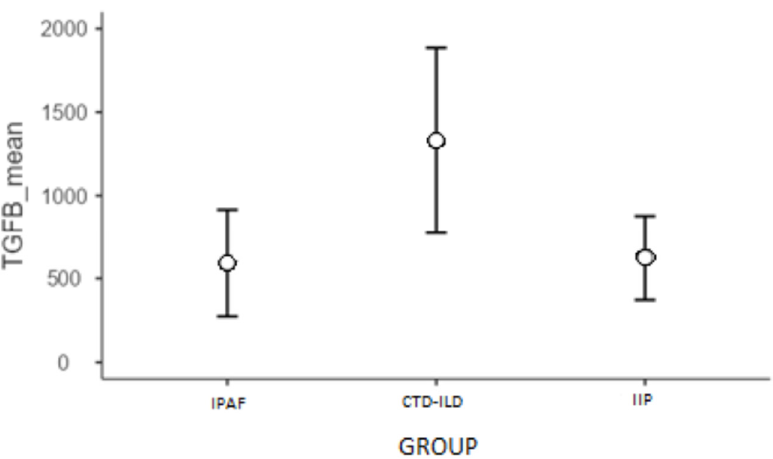
Figure 5. Estimated marginal means for TGF- β 1 by group membership. Graph 2. Estimated marginal means for TGF- β 1 by group membership.